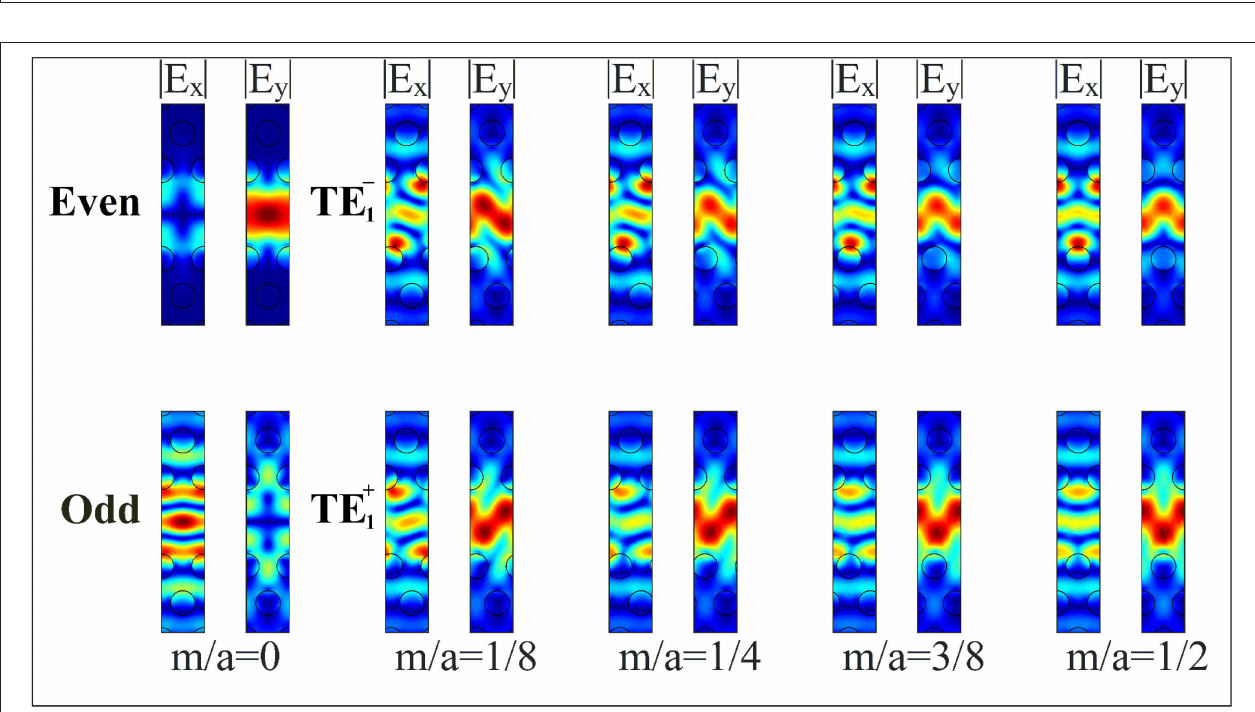
FIGURE 3 | Schematic diagrams for (A) a mode-crossing point with m m 0, which can be looked upon as two split levels. 6=